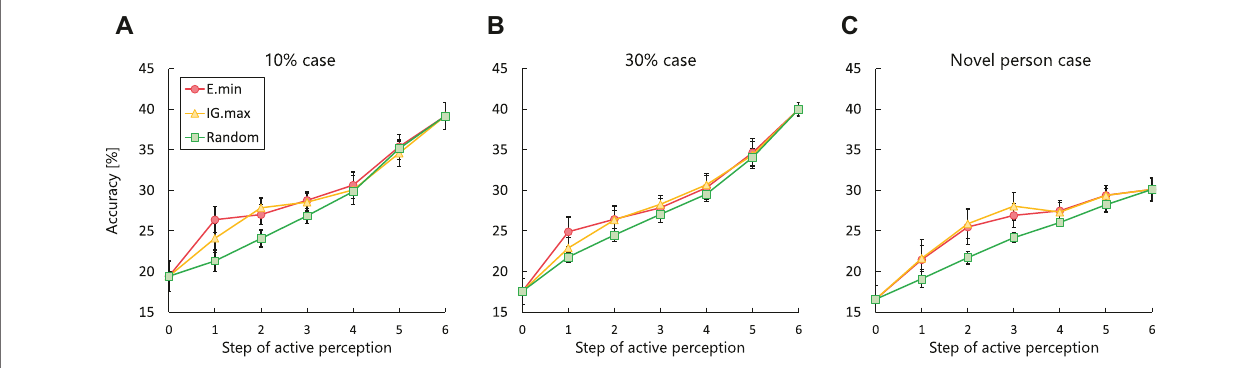
FIGURE 7 | Change in estimation accuracy using each active perception method in all dataset cases: (A) estimation accuracy in the 10% case; (B) estimation accuracy in the 30% case; (C) estimation accuracy in the novel person case.